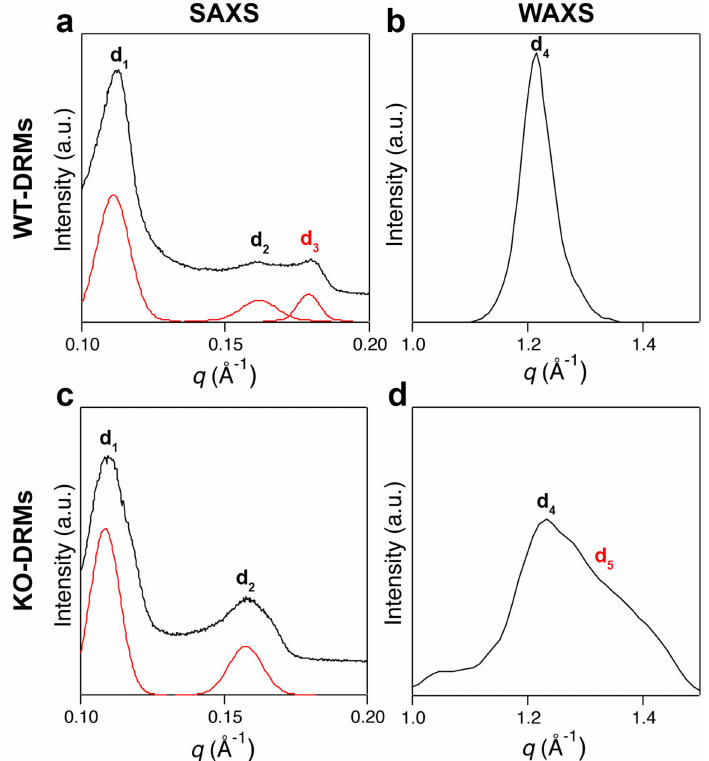
Figure 4. X-ray scattering experiments. ( a ) Small angle X-ray scattering (SAXS) pattern of